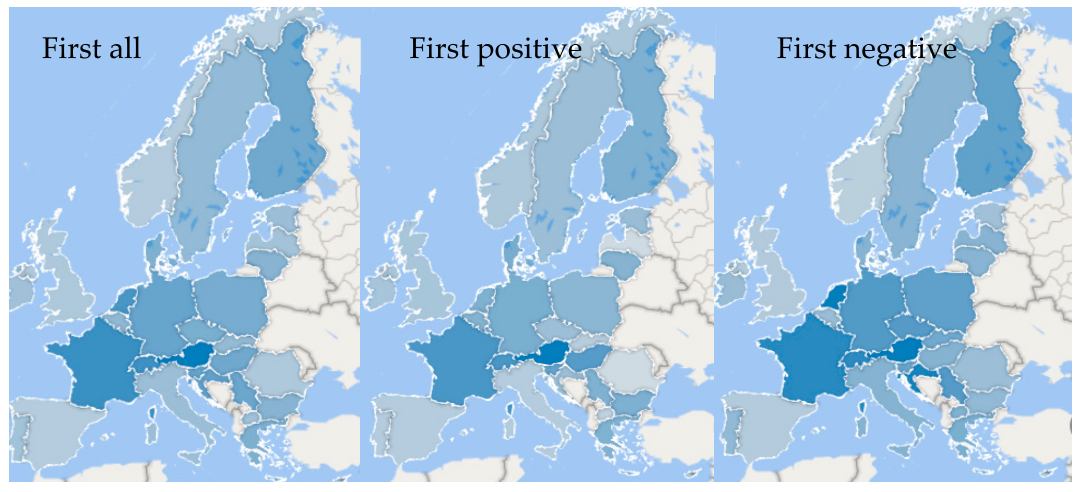
Figure 15. Number of precedence by country, first precedencies, group Edu by effect. Geospatial distribution. A relatively surprising finding is the existence of only six long precedents for positive factors. This indicates a high number of local maxima, but in the case of Switzerland it is not a long